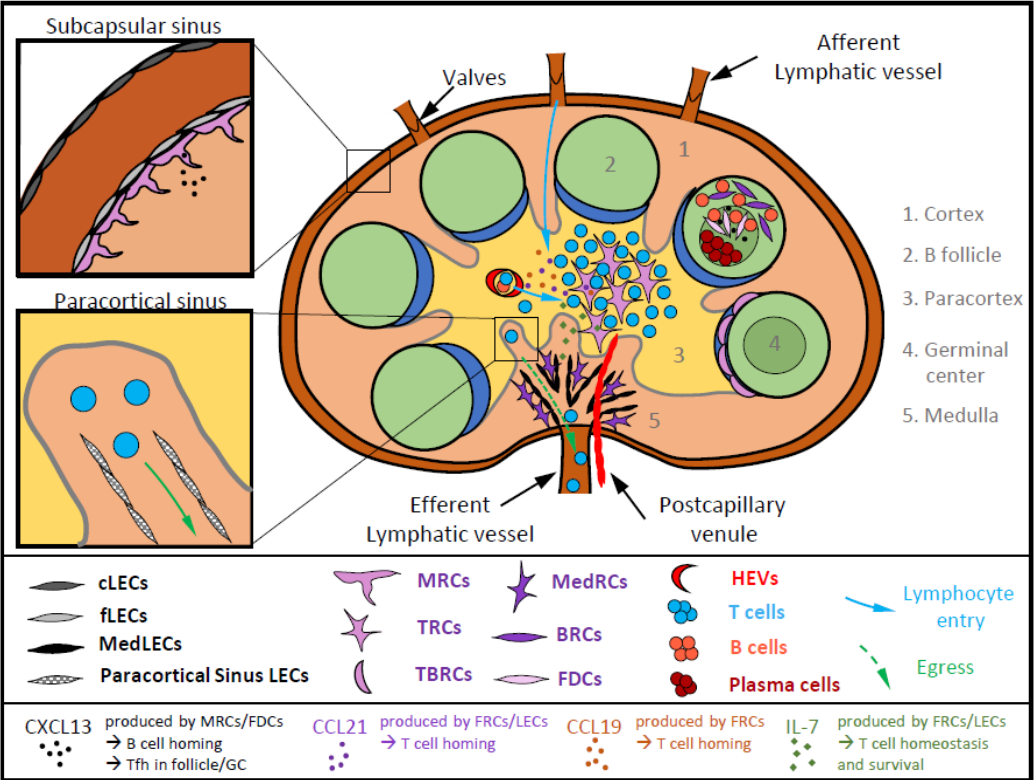
Figure 1. Cartography of different lymph node stromal cell (LNSC) subsets within the LNs. Blood endothelial cells (BECs), fibroblastic reticular cells (FRCs) and lymphatic endothelial cells (LECs) are important components of LNs. Six FRC subsets can be found in different parts of LNs, all producing CCL19 and CCL21, which are important for immune cell homing into the LN. Marginal reticular cells (MRCs) are adjacent to the subcapsular sinus and give rise to follicular dendritic cells (FDCs) in the light zone of germinal centers (GCs). They secrete CXCL13, important for B cell homing and follicular helper T cell attraction in follicle and GCs. B cell reticular cells (BRCs) are also present in GCs, where they are separated by T–B border reticular cells (TBRCs) from the T cell zone (also called paracortex), constituted of T cell reticular cells (TRCs). Medullary reticular cells (MedRCs) are localized in the medullar part, adjacent to efferent lymphatic vessels. LECs, mainly defined as cells lining afferent and efferent lymphatic vessels, have been shown in different locations within LNs and secrete, as FRCS, CCL21. Floor LECs (fLECs) and ceiling LECs (cLECs) compose the outer and the inner part of the subcapsular sinus, respectively. Paracortical sinus LECs are found in paracortical sinuses. Finally, medullary LECs (MedLECs) are in the medullar part of LNs. Both LECS and FRCs secrete IL-7, therefore maintaining T cell homeostasis and survival. BECs form postcapillary venules and high endothelial venules (HEVs), allowing T cells to enter and exit LNs.